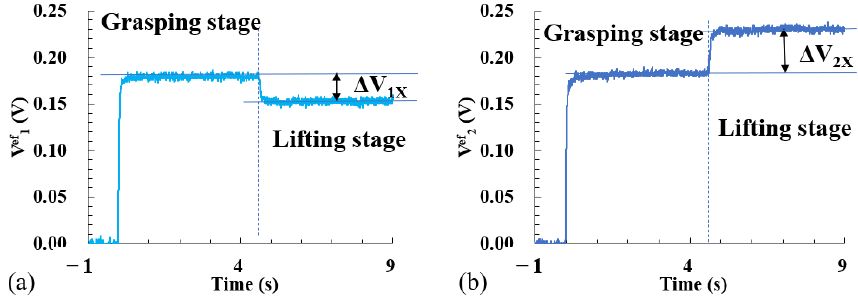
Figure 8. Oscillogram of tactile sensor: ( a ) effective output V ef1 , ( b ) effective output V ef2 . Figure 8b is an oscillogram showing the time variation of V ef2 , which increases by Δ V 2X when transitioning from the grasping stage to the lifting stage.